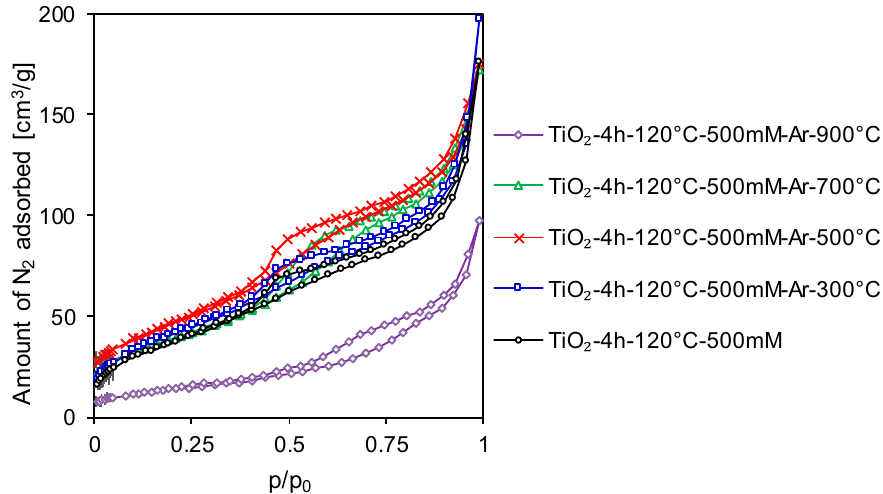
Figure 2. Adsorption/desorption isotherms of APTES-modified TiO 2 prior and after calcination process.